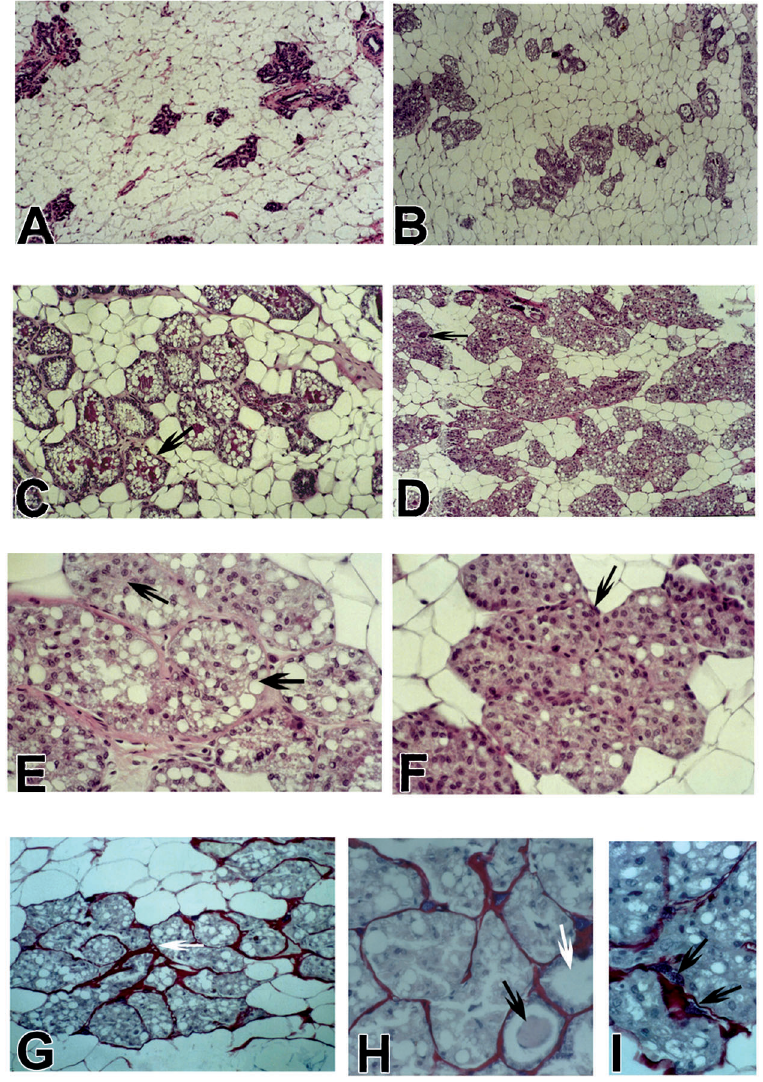
Figure 1. Different morphologic aspects of the mammary gland after 6-month exposure of female rats to testosterone. A , Low power view of the mammary gland of a control rat (100X). B , Testosterone, 30 days. Acinotubular differentiation with secretory activity (100X). C , Testosterone 60 days. Dilated acini (arrow) with secretory activity and with secretion in the lumen (hematoxylin and eosin, H&E, 200X). D , Testosterone 120 days. Persistence of the acinotubular hyperplasia, with the acinar cells filling the acinar lumen. Few acini (arrow) with secretion accumulated in the lumen (H&E, 200X). E , Acini with vacuolated (secretory) epithelial cells filling the lumen (arrows). In some acini there is loss of secretory differentia- tion evidenced by the absence of vacuoles. The nuclear pattern is not altered: there are dark and clear nuclei (H&E, 400X) F , Testosterone 180 days. Acini with epithelial cells filling the lumen, without vacuolization (arrow). In some acini there are vacuolated epithelial cells evidencing persistent secretory activity (H&E, 400X). G , H and I , Testosterone 180 days. Picrosirius red and hematoxylin staining for collagen. In G the white arrow indicates increased intralobular collagen stained in red by sirius red. Epithelial cells with and without secretory activity are filling the acini (200X). In H some acini are dilated, with (black arrow) or without (white arrow) secretory material in the lumen and with hypotrophic acinar epithelial cells (400X). In I the arrows indicate prominent basophilic mast cells stained by hematoxylin